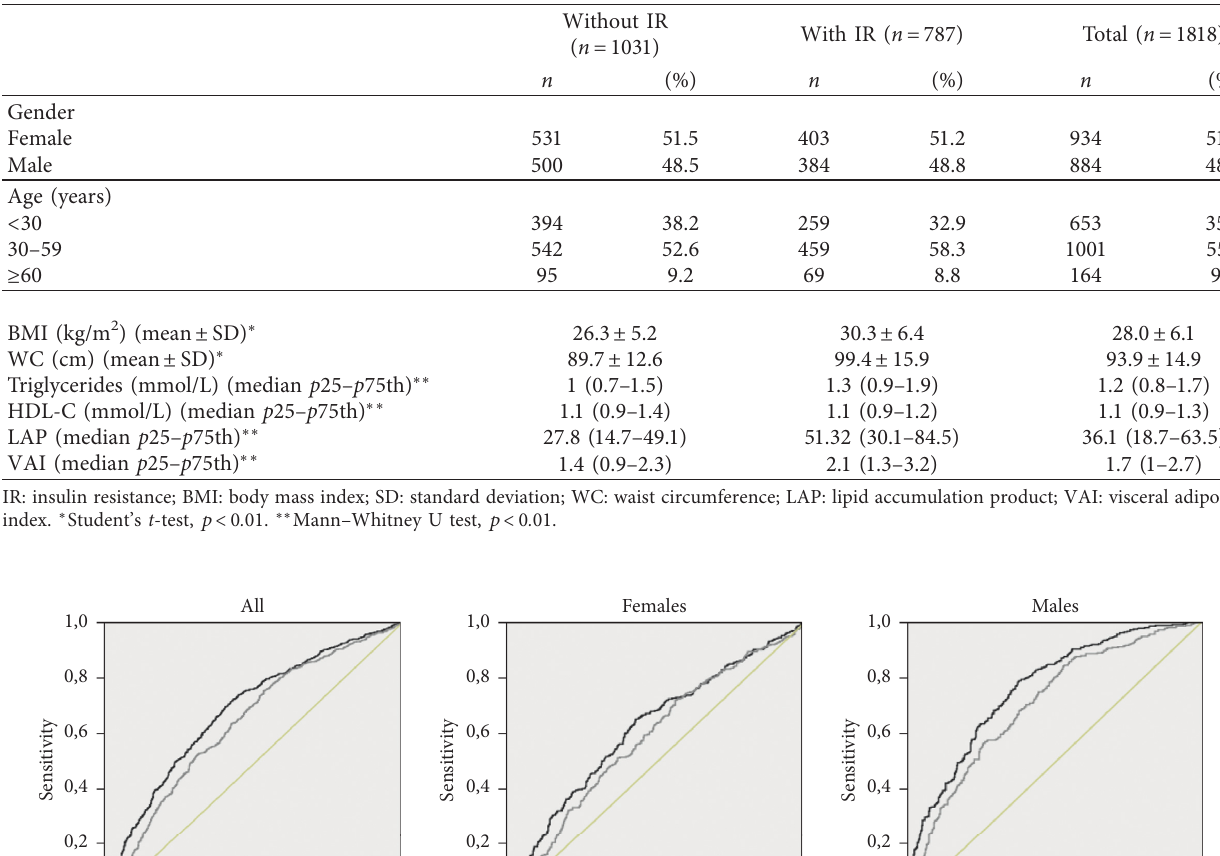
Table 1: General characteristics of the sample (Maracaibo,